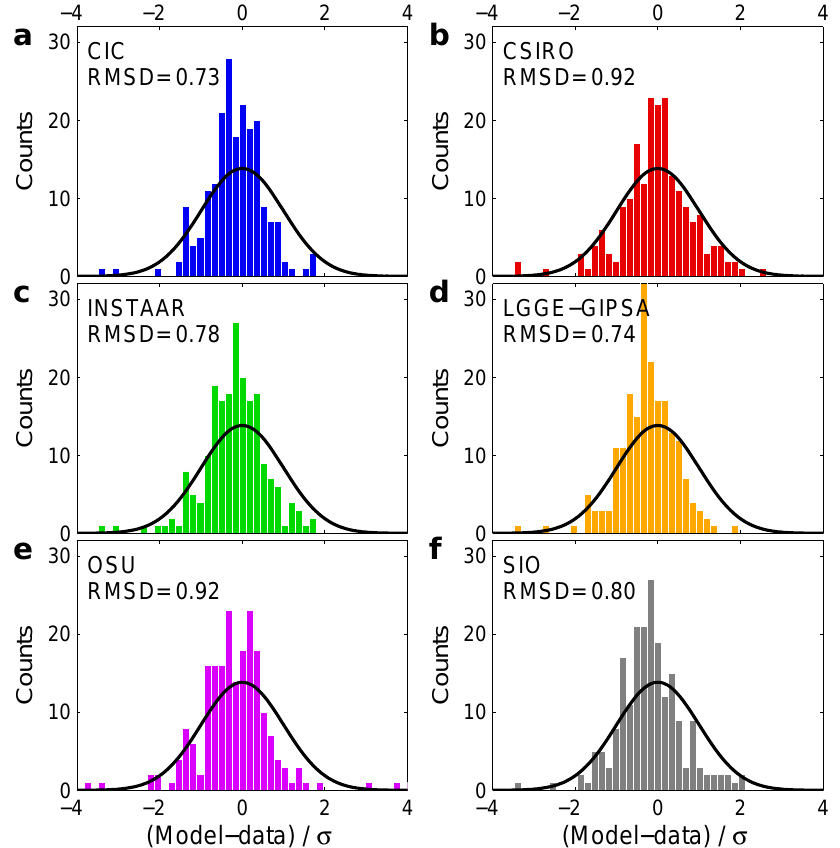
Fig. 4. (a–f) Histogram of (m i − d i )/σ i for the firn air transport models in this study using the EU borehole data. The black curve gives a Gaussian distribution of width σ = 1, normalised to have equal surface to the histogram. The RMSD is calculated using Eq.